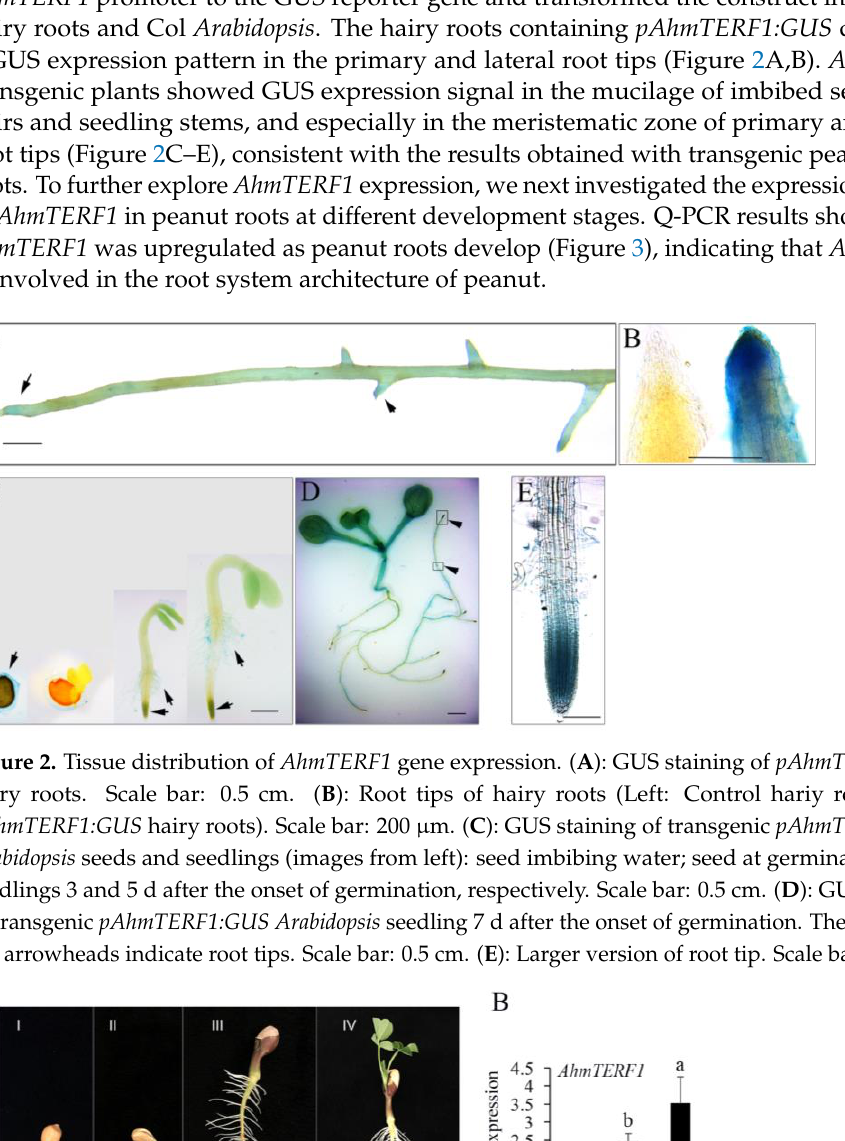
Figure 1. AhmTERF1 affects the growth of peanut hairy roots. ( A ): Phenotype of 20 d-old and 50 d- old peanut hairy roots in control, AhmTERF1 -overexpression ( AhmTERF1-OX ) and AhmTERF1 -si- lenced ( AhmTERF1-RNAi ) lines. ( B ): Proportion of roots of different length, i.e., <3 cm or >3 cm. ( C , D ): Number of primary roots and lateral roots in 20 d-old and 50 d-old seedlings. Lower case letters (a, b, c) indicate significantly different groups ( p < 0.05).